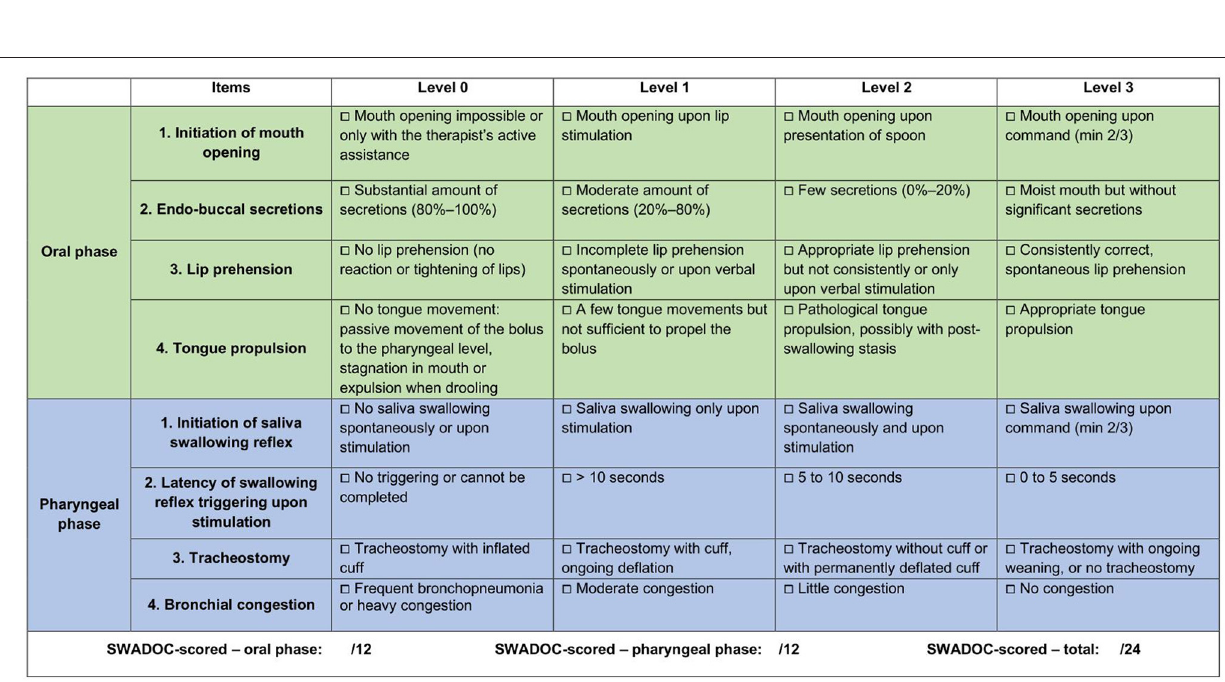
(3) track changes in a patient’s swallowing abilities; and